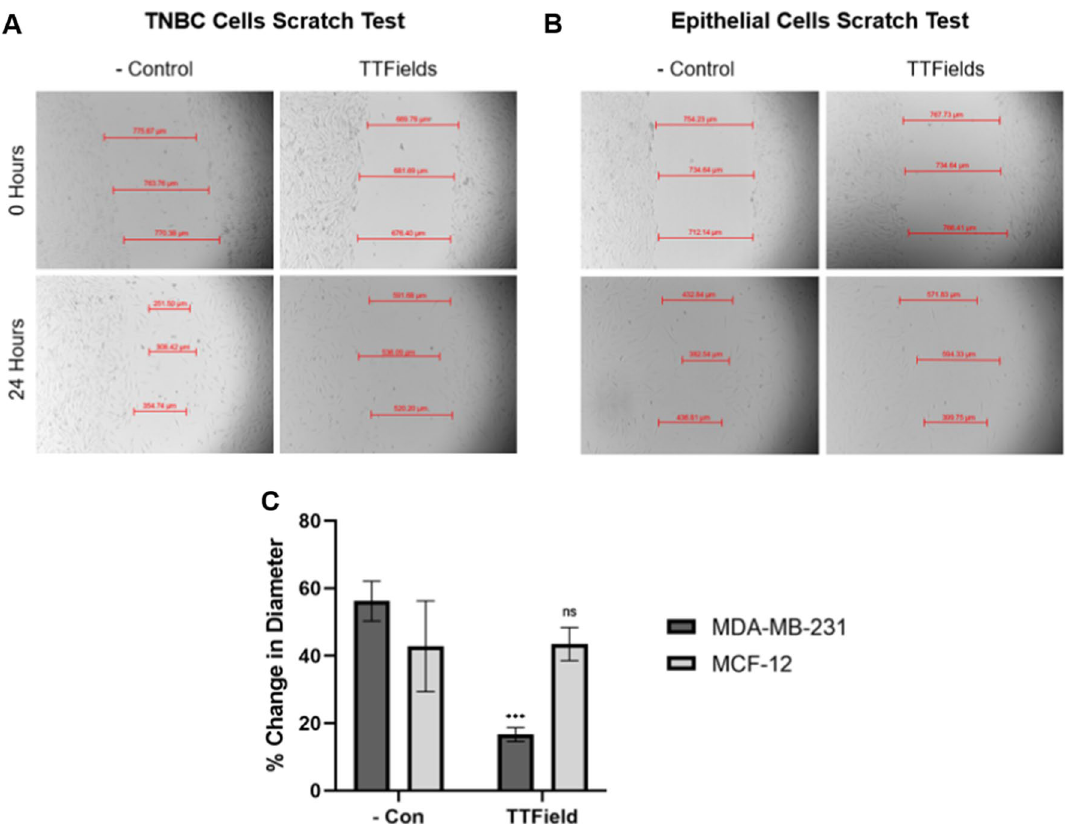
Fig. 6 A scratch test for A TNBC and B epithelial cells after 24 h. TNBC cells were much less likely to occupy the affected area than epithelial cells after receiving 24 h of TTField treatment; the diameter of the wound in TNBC cells stayed much more consistent throughout its entirety as compared to that of epithelial cells. C Measurements were performed on an additional two replicates to the ones shown for a sample size of n = 3. (P < 0.05 = *, P < 0.01 = **, P < 0.001 = ***, P < 0.0001 = ****)